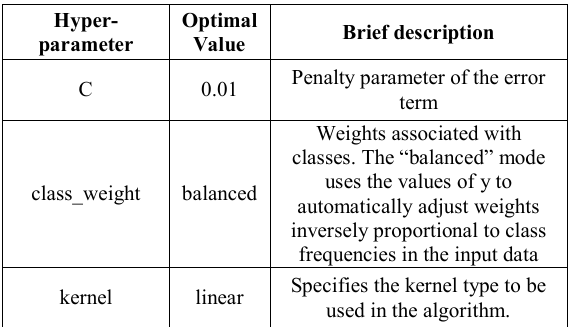
Table 3. Optimal hyperparameters for SVC.